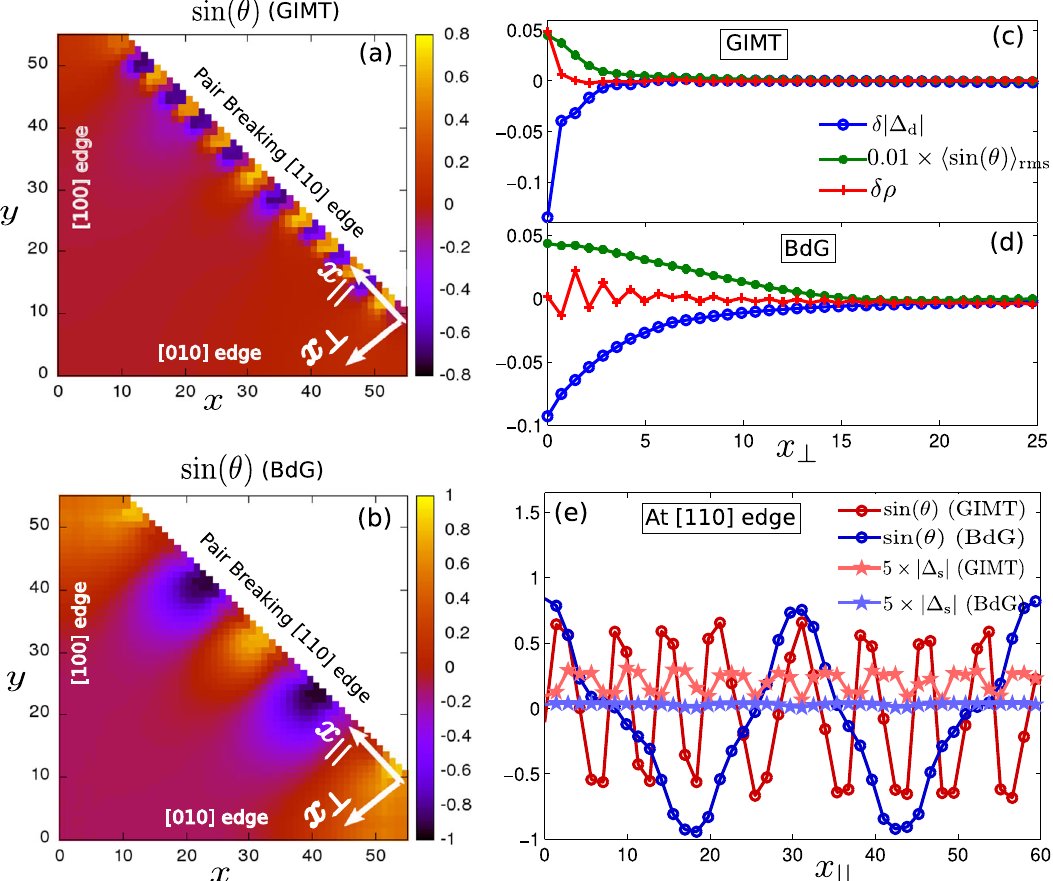
Fig. 1 Phase crystals for clean sample. Color density maps of the phase sin ð θ Þ of the local d -wave superconducting pairing amplitude within GIMT ( a ) and BdG ( b ) at temperature T = 0.01. x ∥ and x ⊥ denote distances along and perpendicular to the pair breaking [110] edge, respectively. c , d Relative change in the magnitude of the d -wave pairing amplitude, de fi ned as δ Δ d j j ¼ h Δ d j ji sin ð θ Þh i , and relative change in the charge density de fi ned as δρ = 〈 ρ 〉 rms − ρ (bulk) plotted as a function of x ⊥ for GIMT and BdG, rms respectively. Here 〈 . . . 〉 rms denotes the root mean square average over all the sites in the x ∥ direction for a fi xed x ⊥ . e Line plots of the phase modulations together with the magnitude of the extended s -wave pairing amplitude Δ s j j at the pair breaking edge. See the “ Methods ” section for remaining